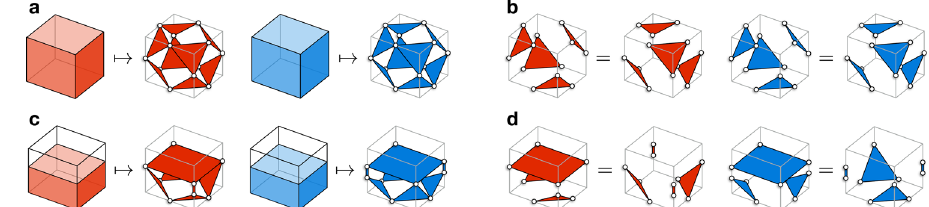
operators. c Theboundary X -and Z -typegaugeoperators. d Theboundary(weight- 10) X -and Z -typestabilizeroperators,whichcanbeformedintwodifferentwaysby multiplying gauge operators.